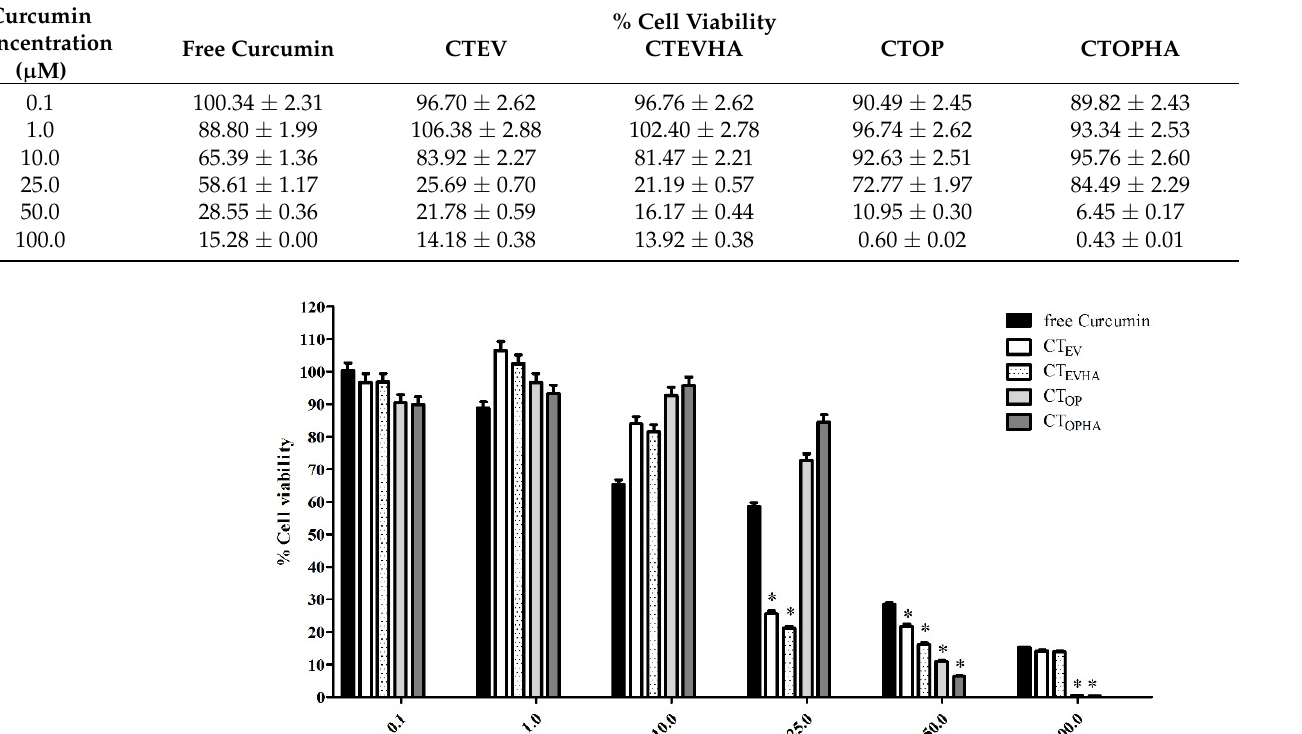
Table 4. Cytotoxicity study of selected turmeric rhizome extract nanoparticles by MTT assay (Mean ± SD, n = 3).